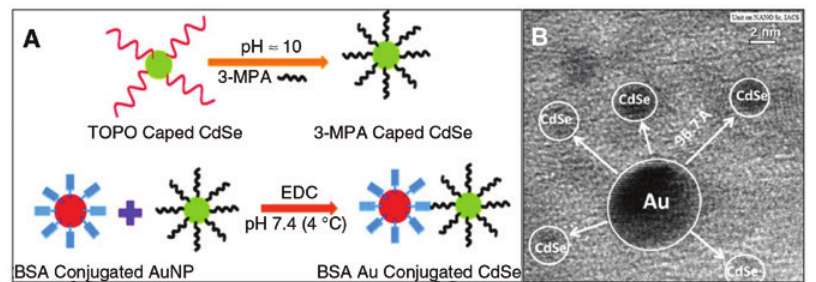
Figure 3: Biomolecular linking of AuNPs and CdSe QDs. (A) Reaction scheme linking CdSe QDs to BSA functionalized AuNPs through EDC coupling. (B) TEM image depicting an AuNP linked to CdSe QDs through BSA. Adapted from Ref. [64]. Copyright 2010 American Chemical